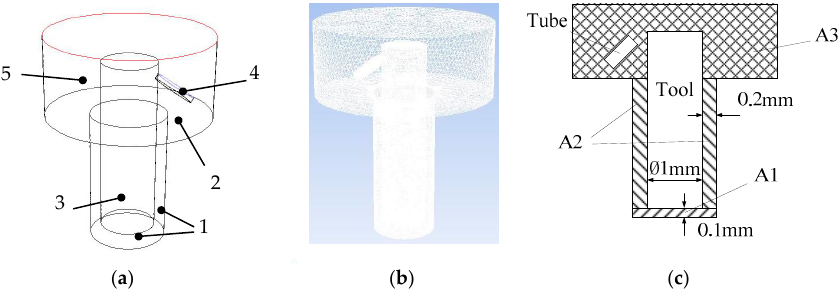
Figure 3. Model of the gap flow field in EDM. ( a ) Three-dimensional (3D) model; ( b ) 3D meshed model; and, ( c ) Schematics of regions.